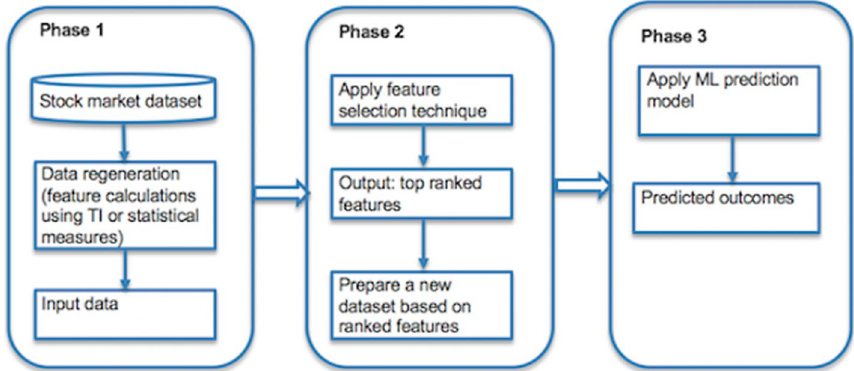
Fig. 1 Phases of the stock market prediction with feature selection and ML method